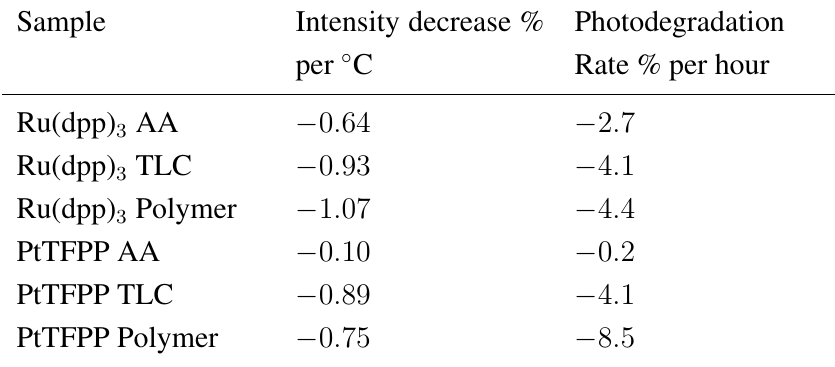
Table 3. Temperature Dependency and